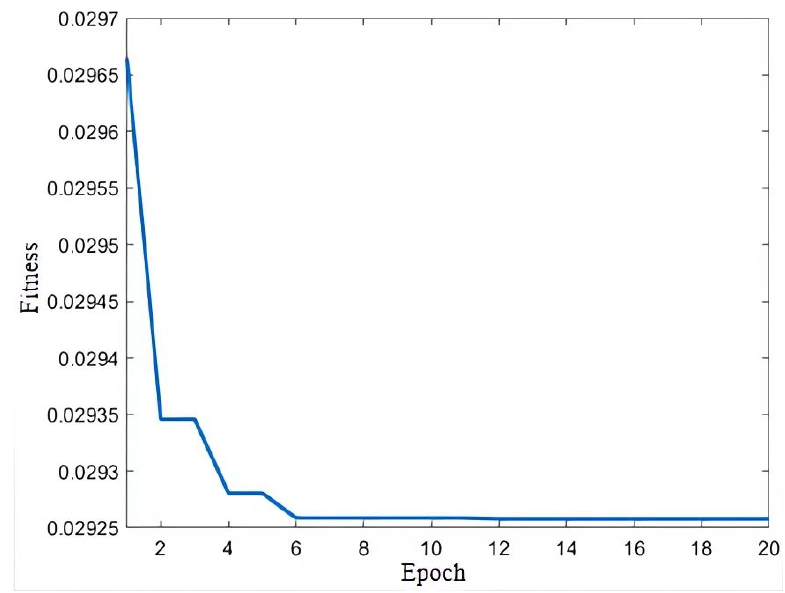
Figure 5. IPSO-VMD fitness iteration graph.